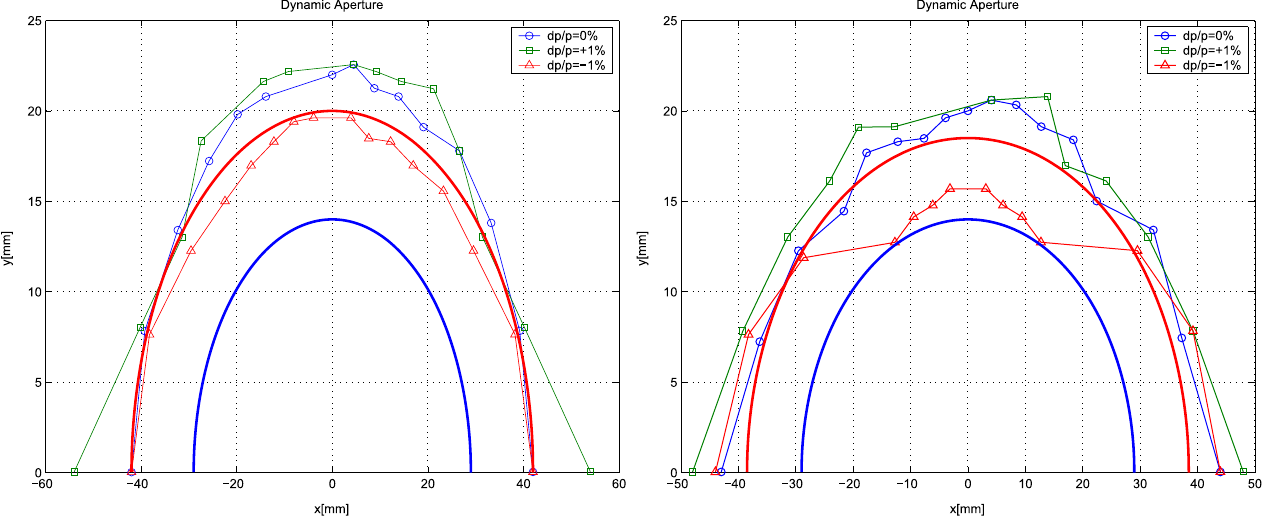
FIG. 10. (Color) Dynamic aperture for the mode with momentum compaction 2 (cid:1) 10 (cid:2) 4 , without errors (left) and with errors